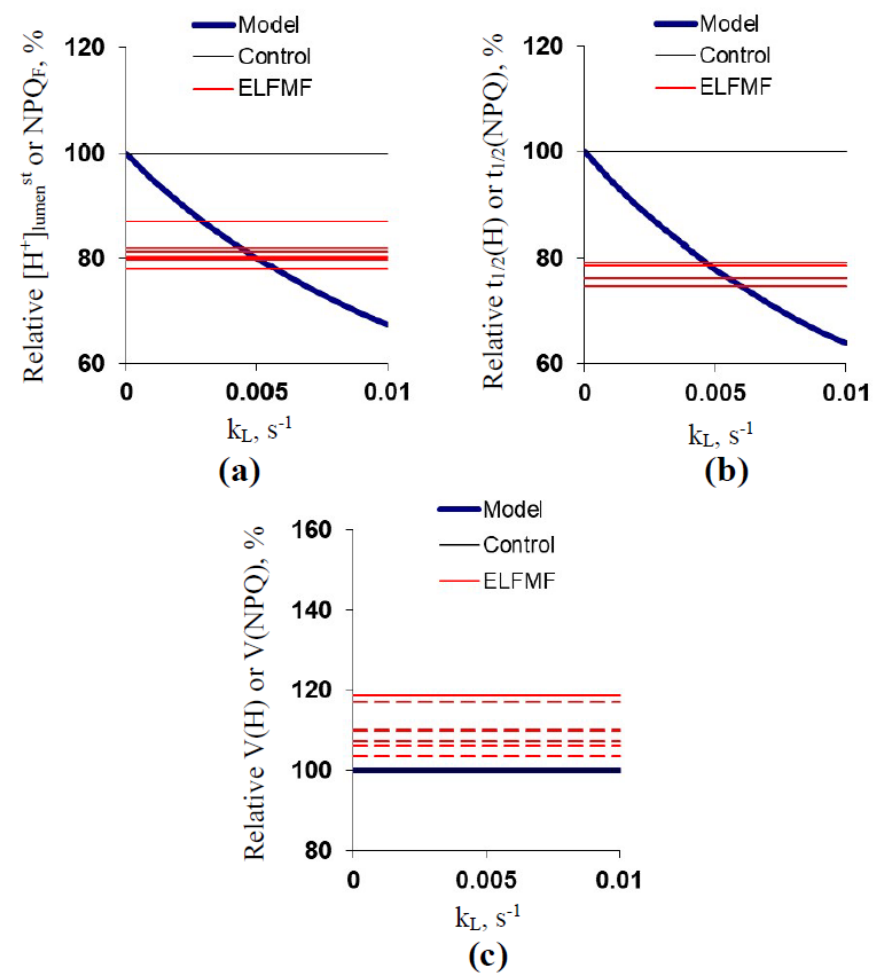
Figure 8. Dependencies of simulated [H + ] lumenst ( a ), t 1/2 (H) ( b ), and V(H) ( c ) on k L . Relative values were calculated as per- centage from simulated values at k ETC = 0.05 s −1 , k S = 0.13 s −1 , and k L = 0 s −1 (see Figure 5b). Figure 8 also shows relative control and experimental averaged values of NPQ F ( a ), t 1/2 (NPQ) ( b ), and V(NPQ) ( c ); the experimental values include all variants of ELFMF treatments (with different ELFMF intensities). The results from Figures 2 and 3 were used. Relative values were calculated as a percentage from control values; standard errors were not included in Figure 8. Dotted lines show experimental parameters, which did not significantly differ from the control.